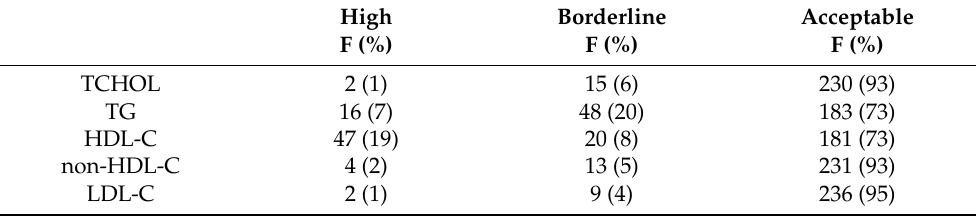
Table 2. Plasma lipid and lipoprotein status in studied adolescents.